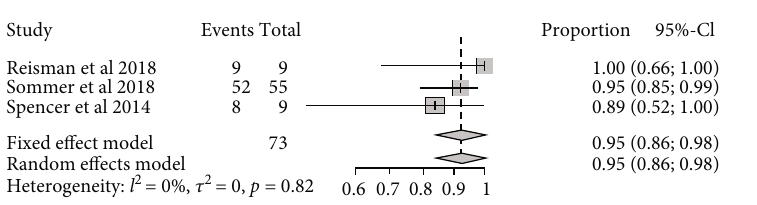
Figure 3: Forest plot of the P2Y12 platelet inhibitor for the rate of migraineurs with the ongoing bene fi t of the responder who underwent PFO closure, after discontinuation of the P2Y12 platelet inhibitor.